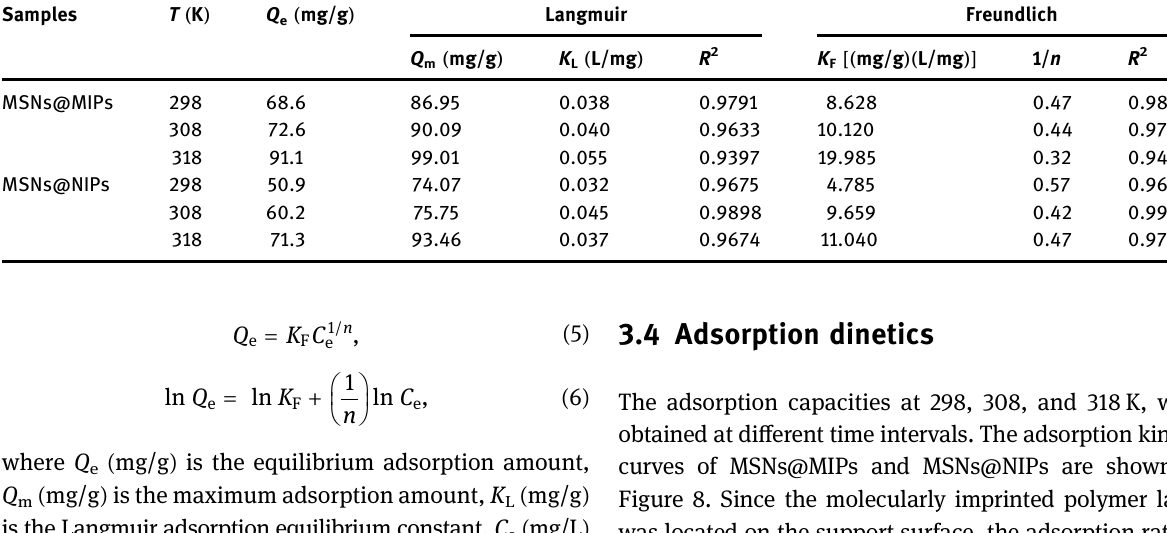
Table 1: Constants of the Langmuir and Freundlich isotherm models Samples